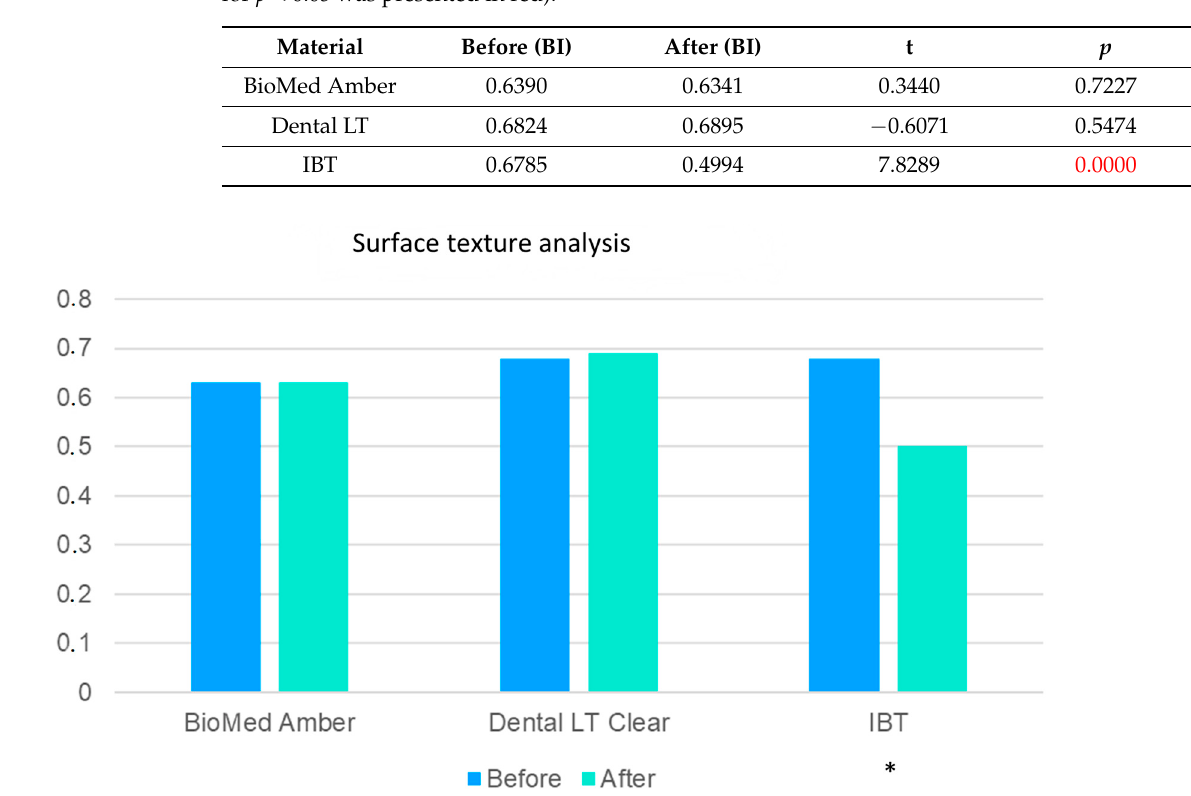
Figure 4. Digital evaluation of the surface structure of the compared materials. The compression test significantly changed the surface appearance of IBT (* means p < 0.001).